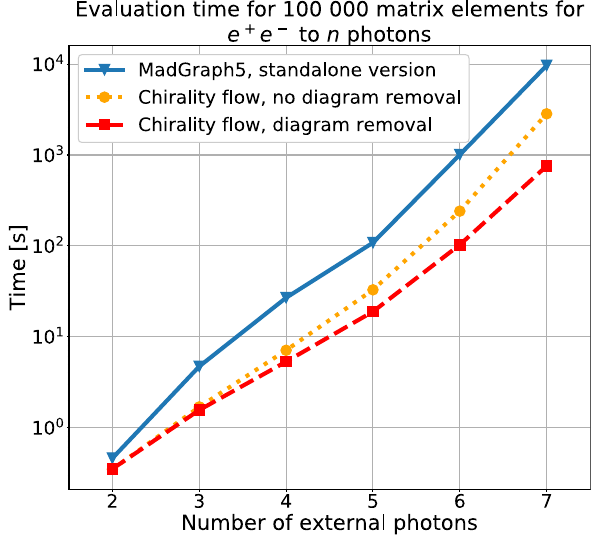
Fig. 1 Measured runtimes for evaluation of 100,000 matrix elements for MG5aMC and our implementation, as a function of photon mul- tiplicity n . The dotted orange curve depicts the chirality-flow imple- mentation without gauge based diagram removal, whereas the dashed red curve includes gauge based diagram removal. The same number of helicity/chiralityconfigurations are evaluatedin allcases. The chirality- flow implementations evaluate matrix elements faster than MG5aMC for all n . For small n the gain can be explained almost fully by sim- plified calculations, but for larger n the effects of gauge based diagram removal become readily